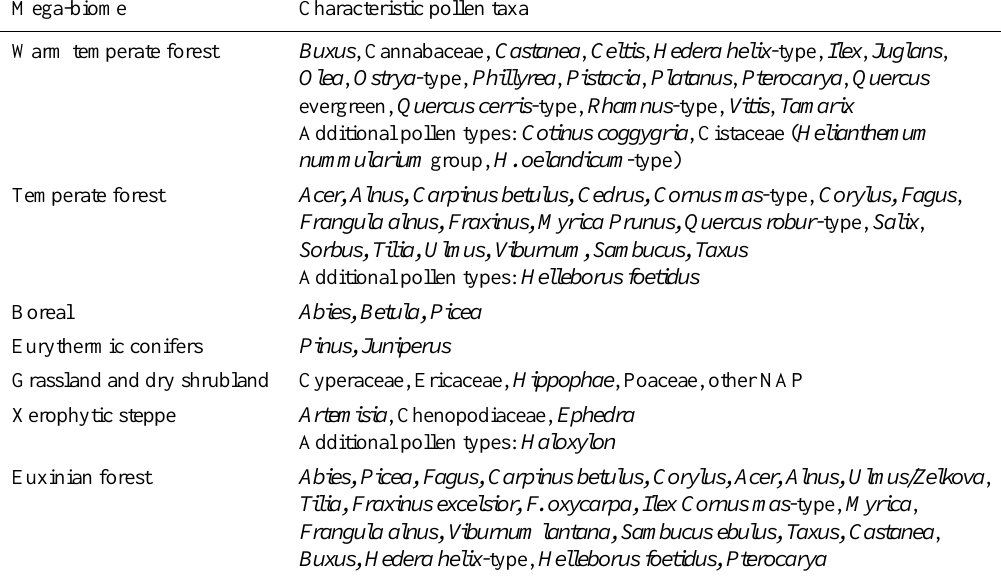
Table 1. Definition of mega-biomes for Europe based on Fletcher et al. (2010) and the northern Anatolian Euxinian forest. Mega-biome Characteristic pollen taxa Warm temperate forest Buxus , Cannabaceae, Castanea , Celtis , Hedera helix -type, Ilex , Juglans